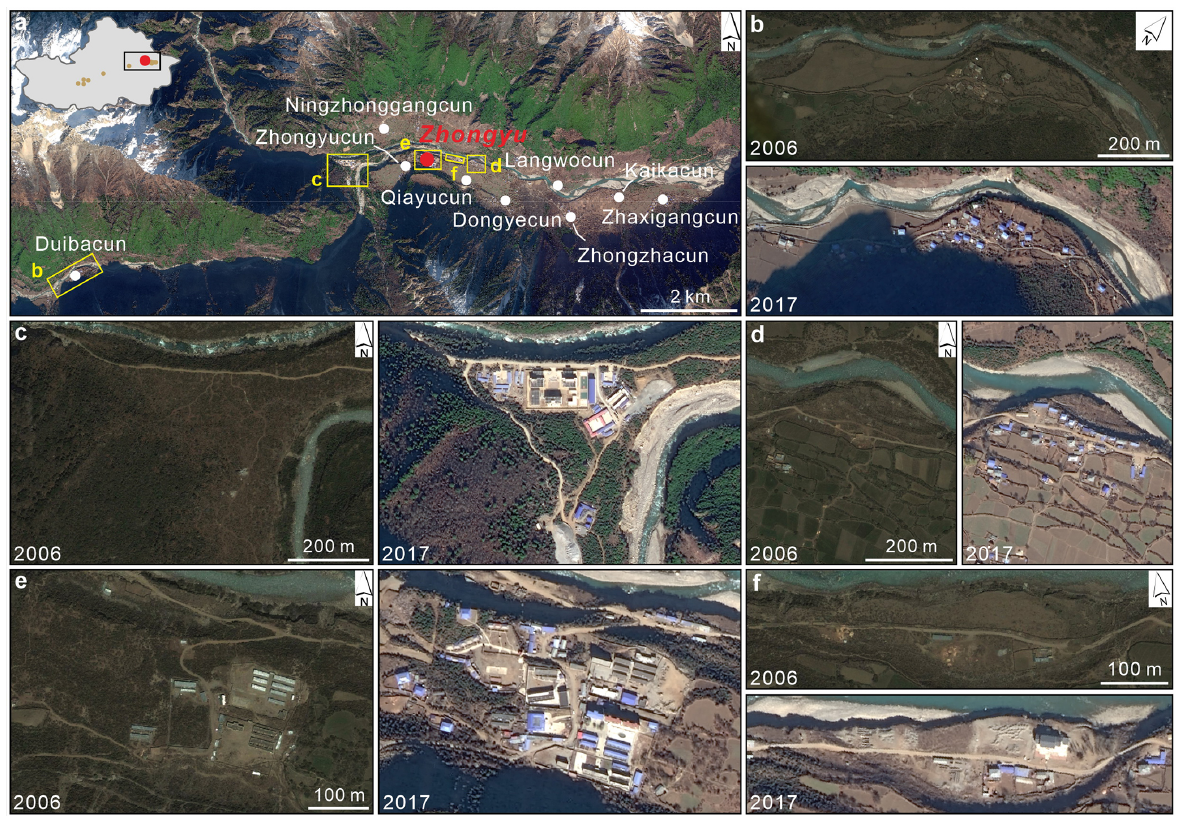
Figure 13. Examples of rapid development and expansion of the villages of lower Zhongyu township during 2006–2017. The background of panel (a) and the satellite scenes for the 2017 panels are a true-color composite Gaofen-2 image acquired on 7 December 2017. The satellite images for the 2006 panels are from © Google Earth, acquired on 30 April